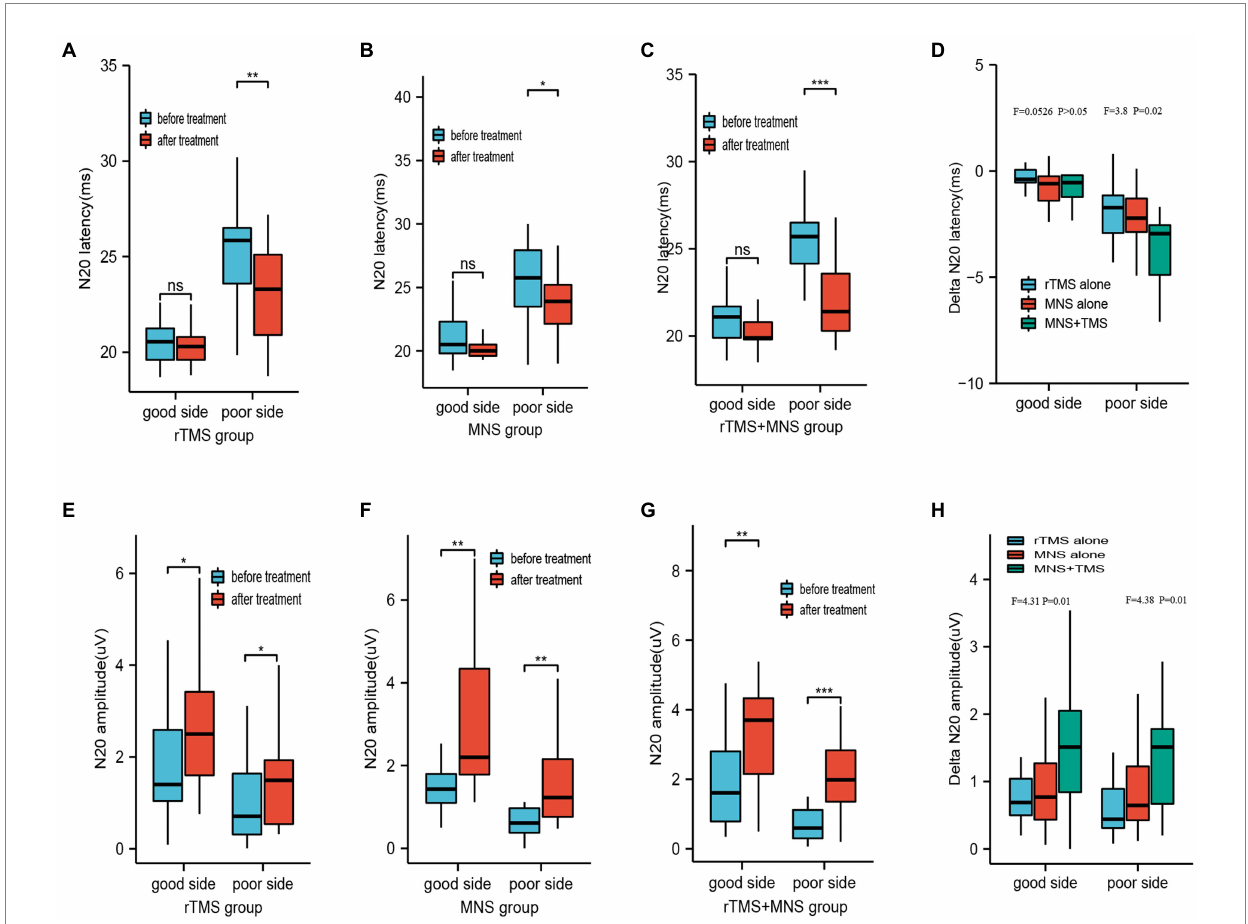
FIGURE 4 Latency and amplitude of N20 following 4 weeks of treatment for the rTMS alone, MNS alone and rTMS+MNS groups. A significant decrease in the latency of N20 on the poor sides after intervention compared with the baseline values in the (A) rTMS alone, (B) MNS alone and (C) rTMS+MNS, whereas the decrease measured on the “good” side were not. (D) The changes in latency of N20 on poor side between the three groups were statistically significant. No statistically significant changes in latency of N20 on good side between the three groups were showed. A significant increase in the amplitude of N20 on the both side compared with pre-treatment in the (E) rTMS alone, (F) MNS alone and (G) rTMS+MNS. (H) The changes in amplitude of N20 on both side between the three groups were statistically significant. rTMS, repetitive transcranial magnetic stimulation; MNS, median nerve stimulation; *means p < 0.05, **means p < 0.01, ***means p <